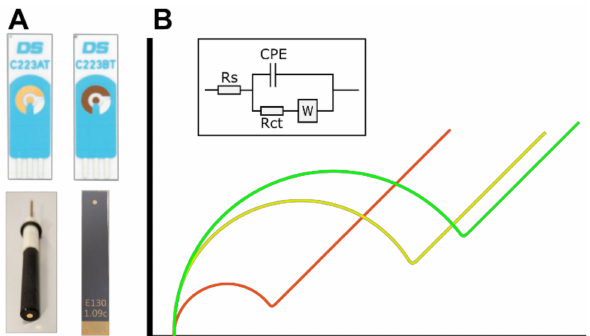
Figure 1. ( A ) Images of electrodes used in these experiments. From top left to bottom right; AT screen-printed electrode, BT screen-printed electrode, polycrystalline gold electrode, thin-film gold electrode. ( B ) Example impedance responses of electrodes which are clean (red), modified with a self-assembled monolayer (SAM) and probe layer (yellow), and with DNA target bound to the probe (green). Inset: the Randles equivalent circuit used to fit impedance data; Rs—solution resistance, CPE—constant phase element, Rct—charge transfer resistance, W—Warburg